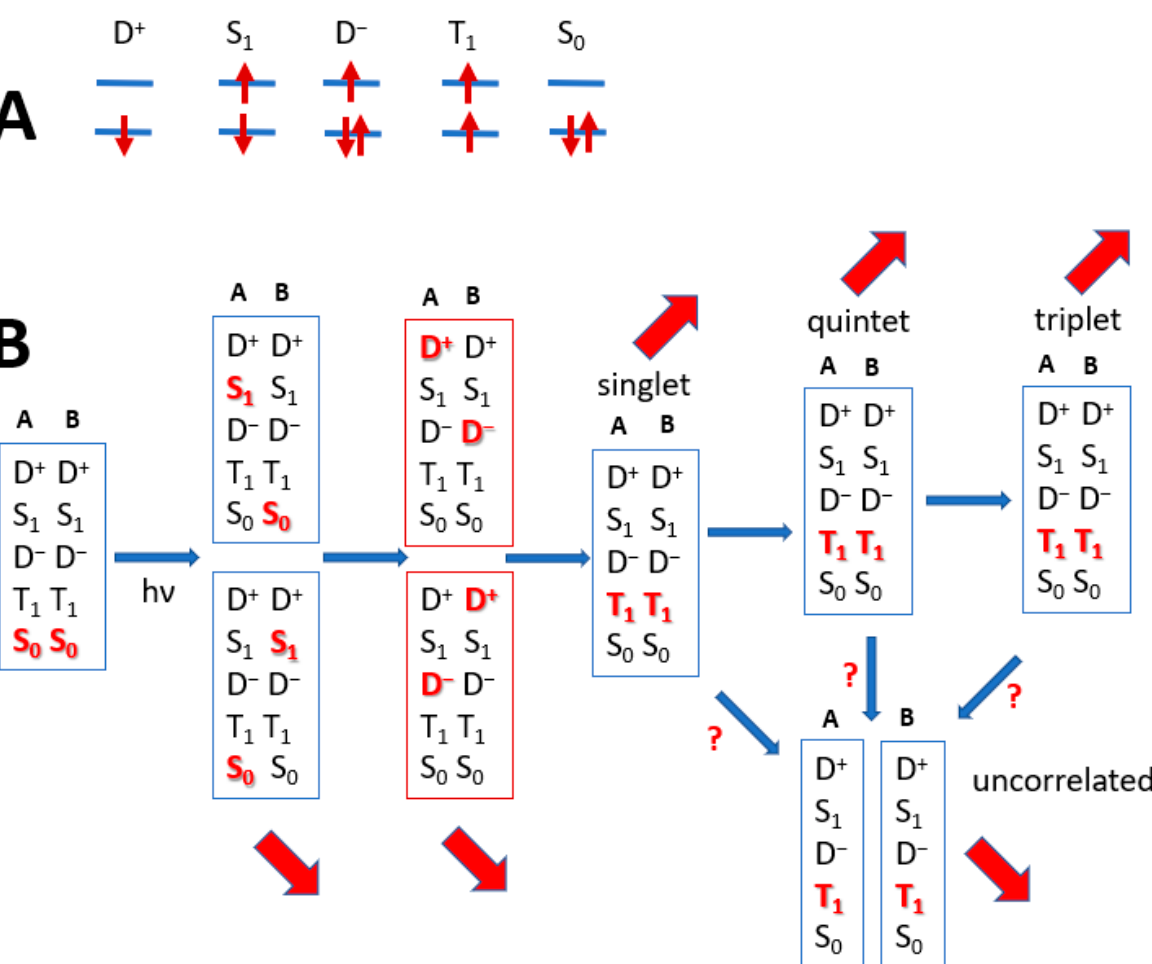
Figure 3. A: Symbolic representation of states available to molecules A and B. B: The general mechanism of singlet fission. The possible electronic configurations of partners A and B are listed in black and the actually occupied configuration is shown in red. Frames located above each other indicate the sets of configurations that need to be mixed to form a state. Black frames indicate real states and red frames show states that usually are only virtual. Thin blue arrows indicate the path for singlet fission and fat red arrows indicate undesirable decay channels. See